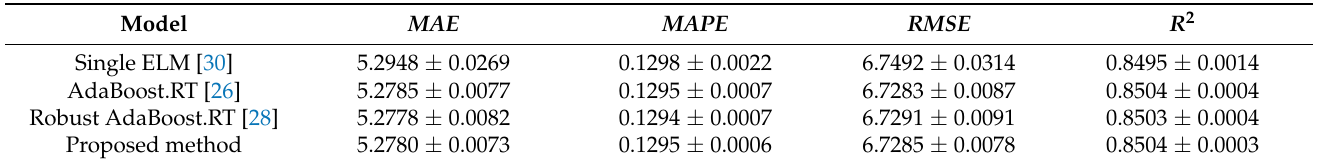
Table 6. Comparison of test performance of different models.